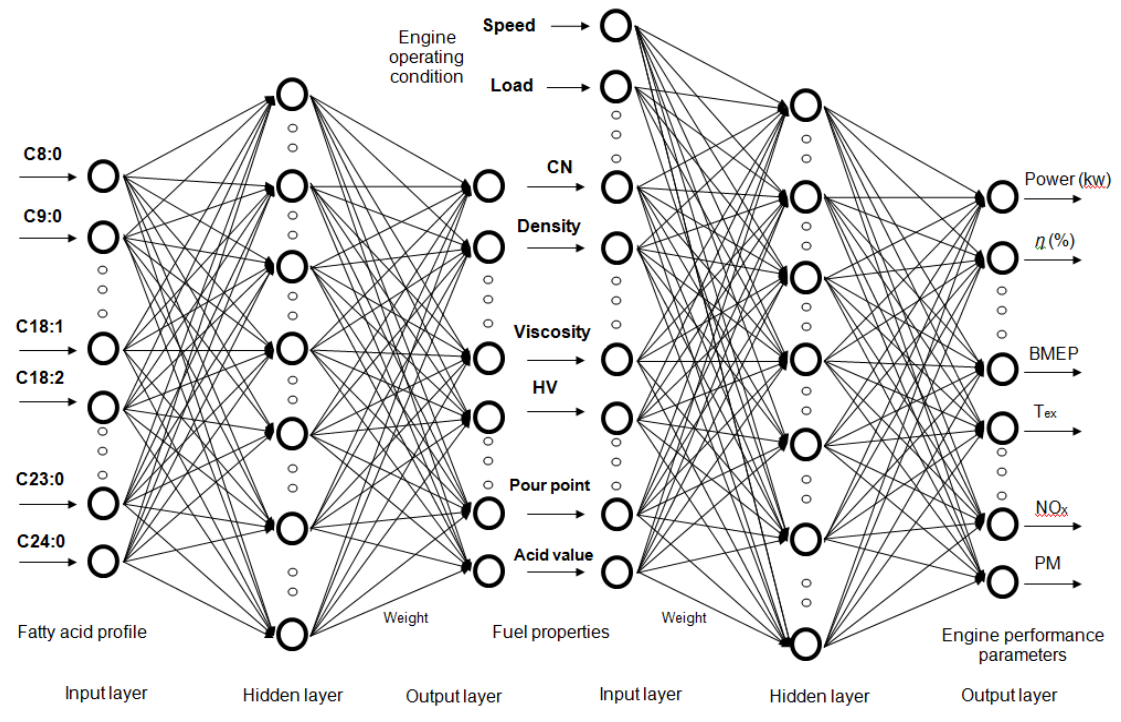
Figure 12. Proposed structure of ANN